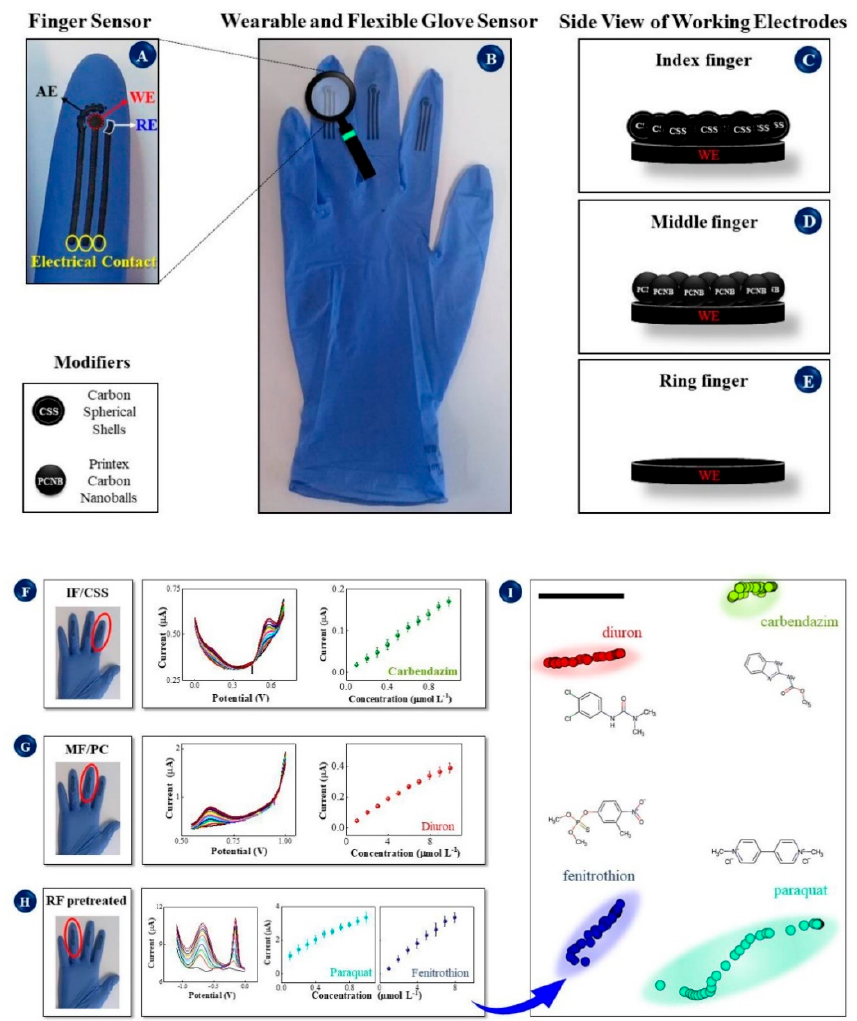
Figure 10. ( A ) Details of finger sensor design with a complete electrochemical system: auxiliary, reference and working electrodes. The connection between electrodes and potentiostat was made via flexible conductive wires for on-site detection. ( B ) Image of the real screen-printed sensing glove. ( C – E ) Schematic representation of the side views of CSS, PCNB and pretreated sensing layers for index, middle and ring fingers, respectively. The electrochemical signatures and corresponding analytical curves obtained with index, middle and ring fingers of the glove-embedded sensors are shown in ( F ) through ( H , F ) DPV for carbendazim detection from 1.0 × 10 − 7 to 1.0 × 10 − 6 mol L –1 ; ( G ) DPV for diuron detection from 1.0 × 10 − 7 to 1.0 × 10 − 6 mol L –1 ; ( H ) SW voltammograms for paraquat detection from 1.0 × 10 − 7 to 1.0 × 10 − 6 mol L − 1 and fenitrothion detection from 1.0 × 10 − 7 to 1.0 × 10 − 6 mol L − 1 . Conditions for the detection: 0.1 mol L − 1 phosphate buffer solution, pH 7.0. ( I ) LSP plot for all pesticides measured with differential pulse and square wave voltammetry, where each voltammogram was converted into a colored dot on the plot. The black bar is only a guide to measure distances between data points. The silhouette coefficient is 0.79. Reprinted with permission from [166] Copyright 2021